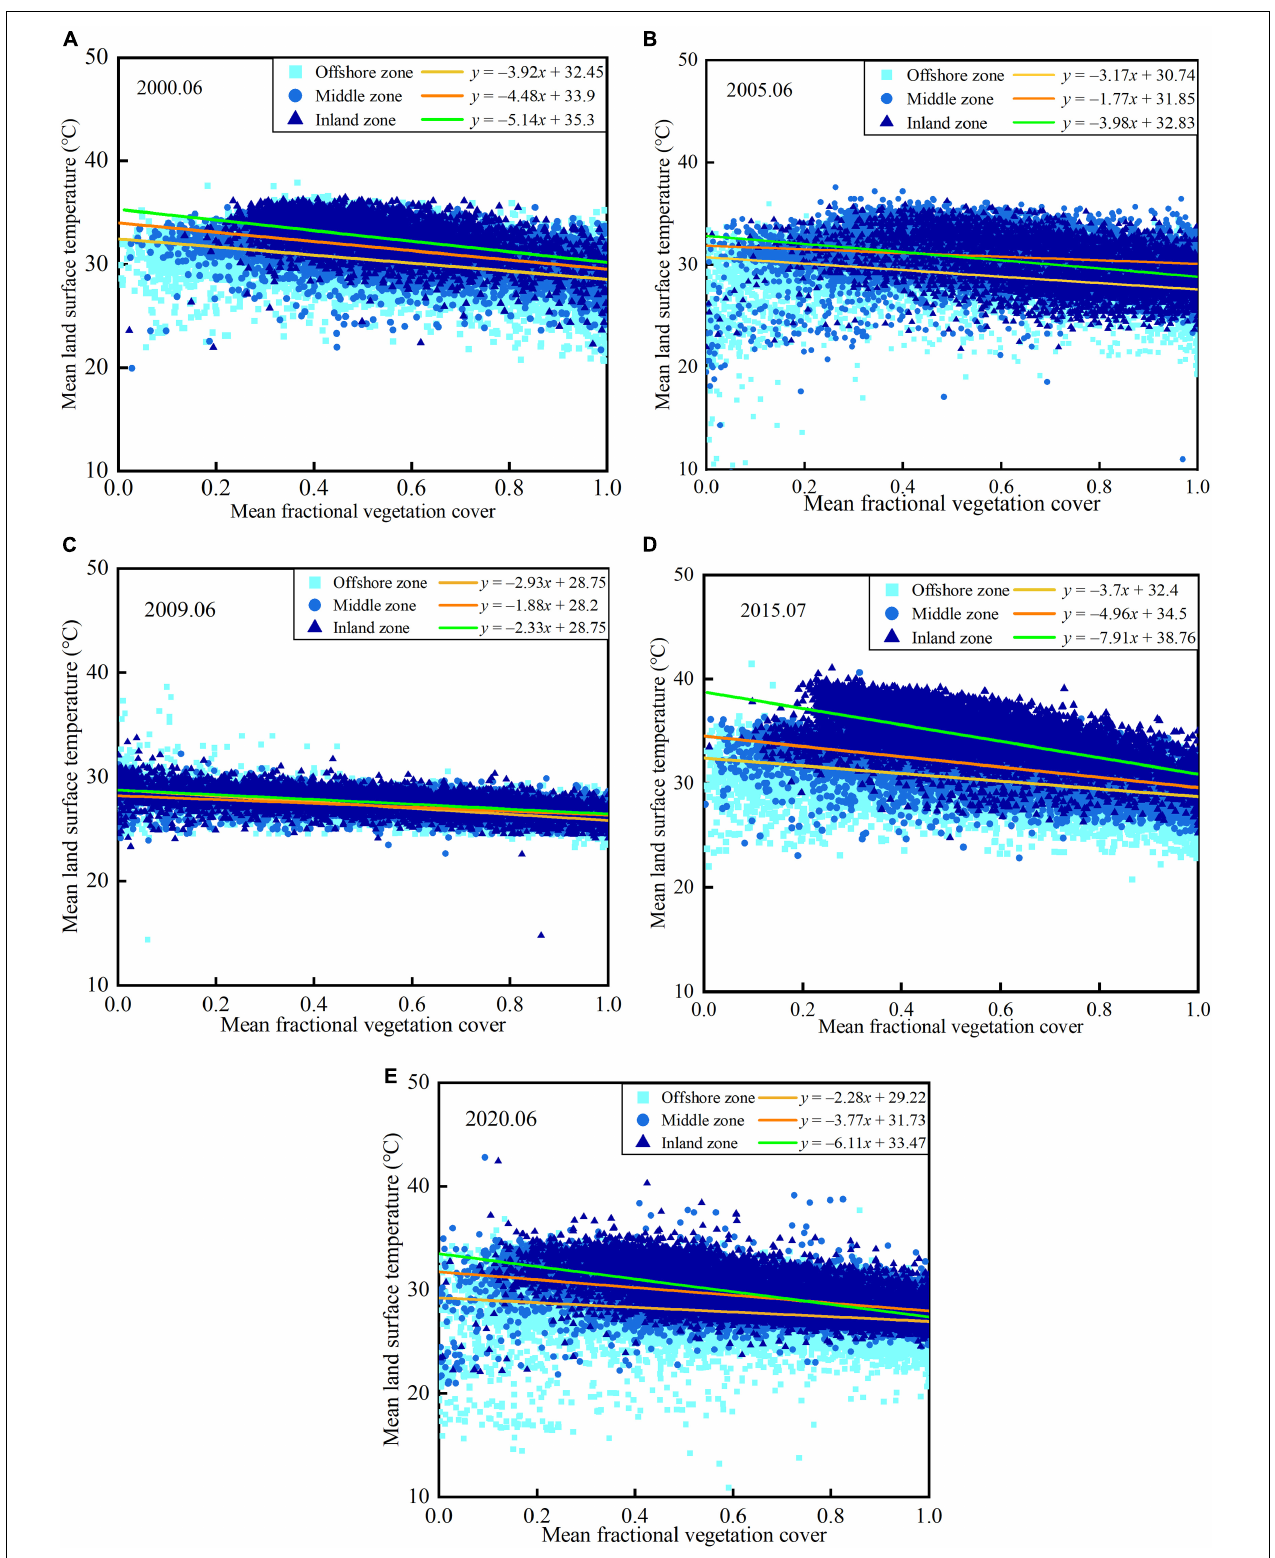
FIGURE 10 | Variation of land surface temperature and fractional vegetation cover in different zones (A) 2000.06, (B) 2005.06, (C) 2009.06, (D) 2015.07, and (E) 2020.06.